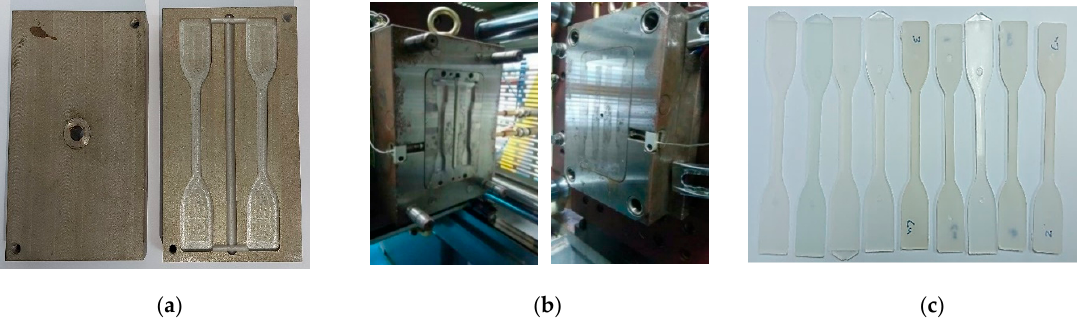
Figure 12. ( a ) MEC mold inserts; ( b ) mold inserts installed to mold based for injection molding process; ( c ) ejected parts.